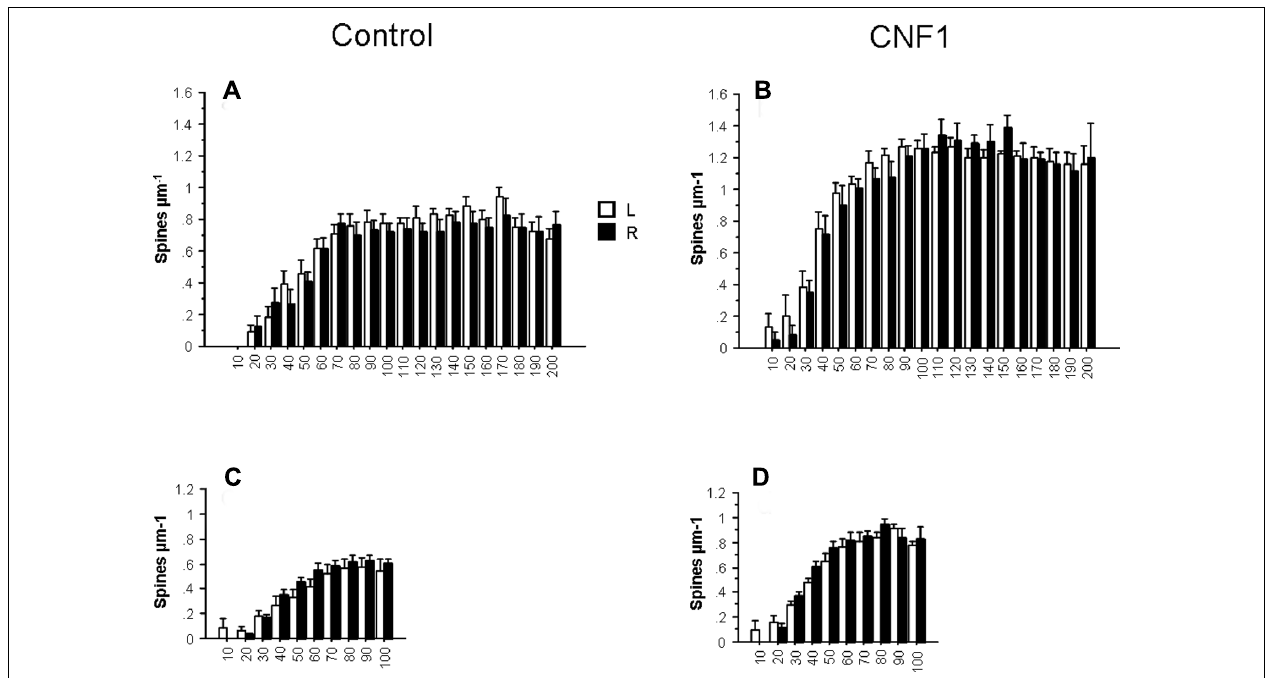
FIGURE 5 | Effects of Rho GTPase activation on spine density by cerebral hemisphere. The analysis of spine density by distance from cell soma ( μ m) in hippocampal CA1 pyramidal neurons of the left (L, n = 16) and right (R,